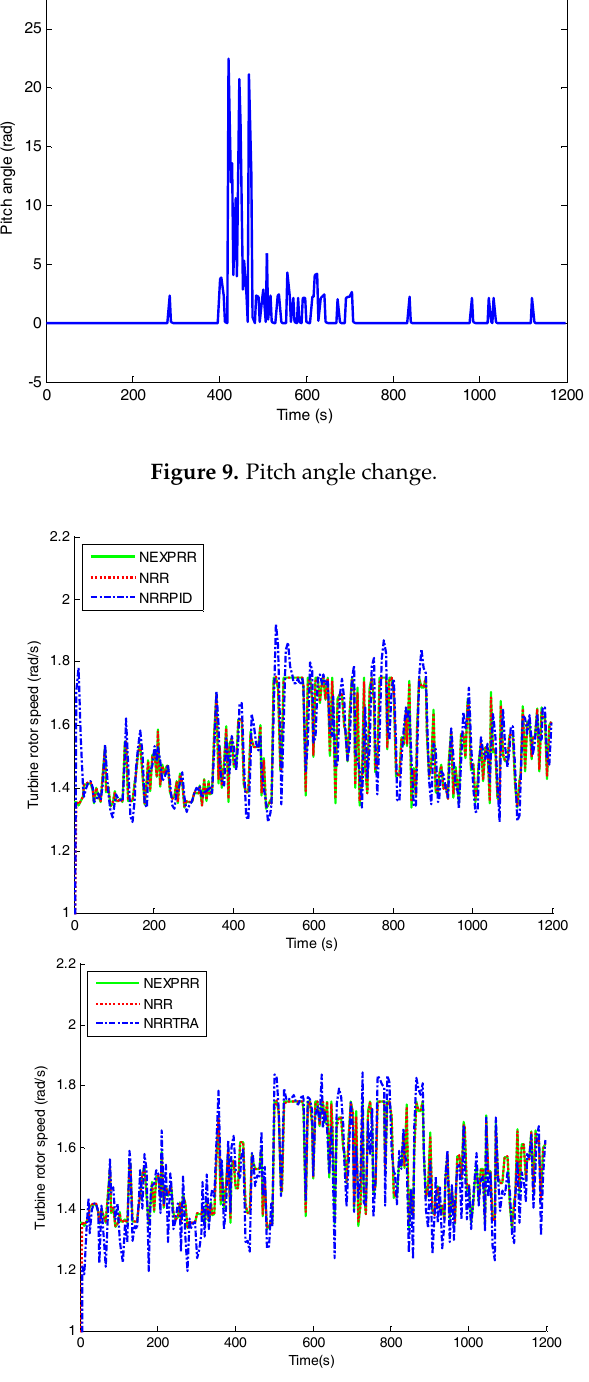
Figure 11. Turbine rotor speed error. Figure 11 presents the turbine rotor speed error given by the three controllers in pairwise comparison, where the second order sliding mode control gives quite a small error, implying smaller chattering and higher stability. It is also observed that the power output by each controller follows a similar trend but the total energy output with the second order sliding mode method is slightly higher than with the other two control methods. Clearly, the newly designed controller has better performance than PID and the conventional sliding mode controller, as shown in Table 4. Table 4. Simulation results of turbine rotor speed, speed error and output power. Simulation Output